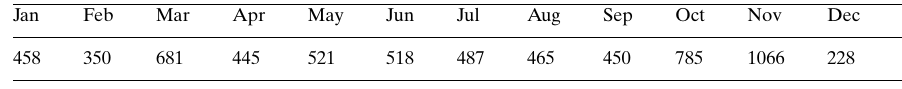
Papers submitted in each month of